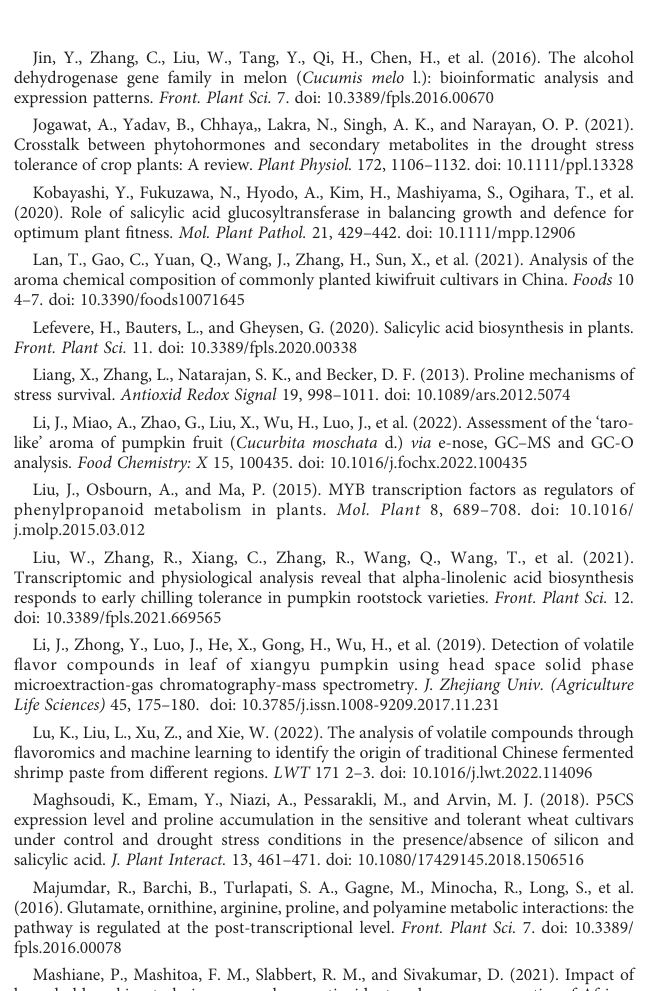
SUPPLEMENTARY FIGURE 2 Regulated MYC2 TFs in Zn treated pumpkin leaves. (A) MEGA sequence alignment and phylogenetic tree analysis using the regulated MYC2 TFs and AtMYC2. (B) NCBI CD-search prediction of CmoCh16G012080 and AtMYC2. (C) Homologous sequence alignment of CmoCh16G012080 and AtMYC2 using the online tool Clustal